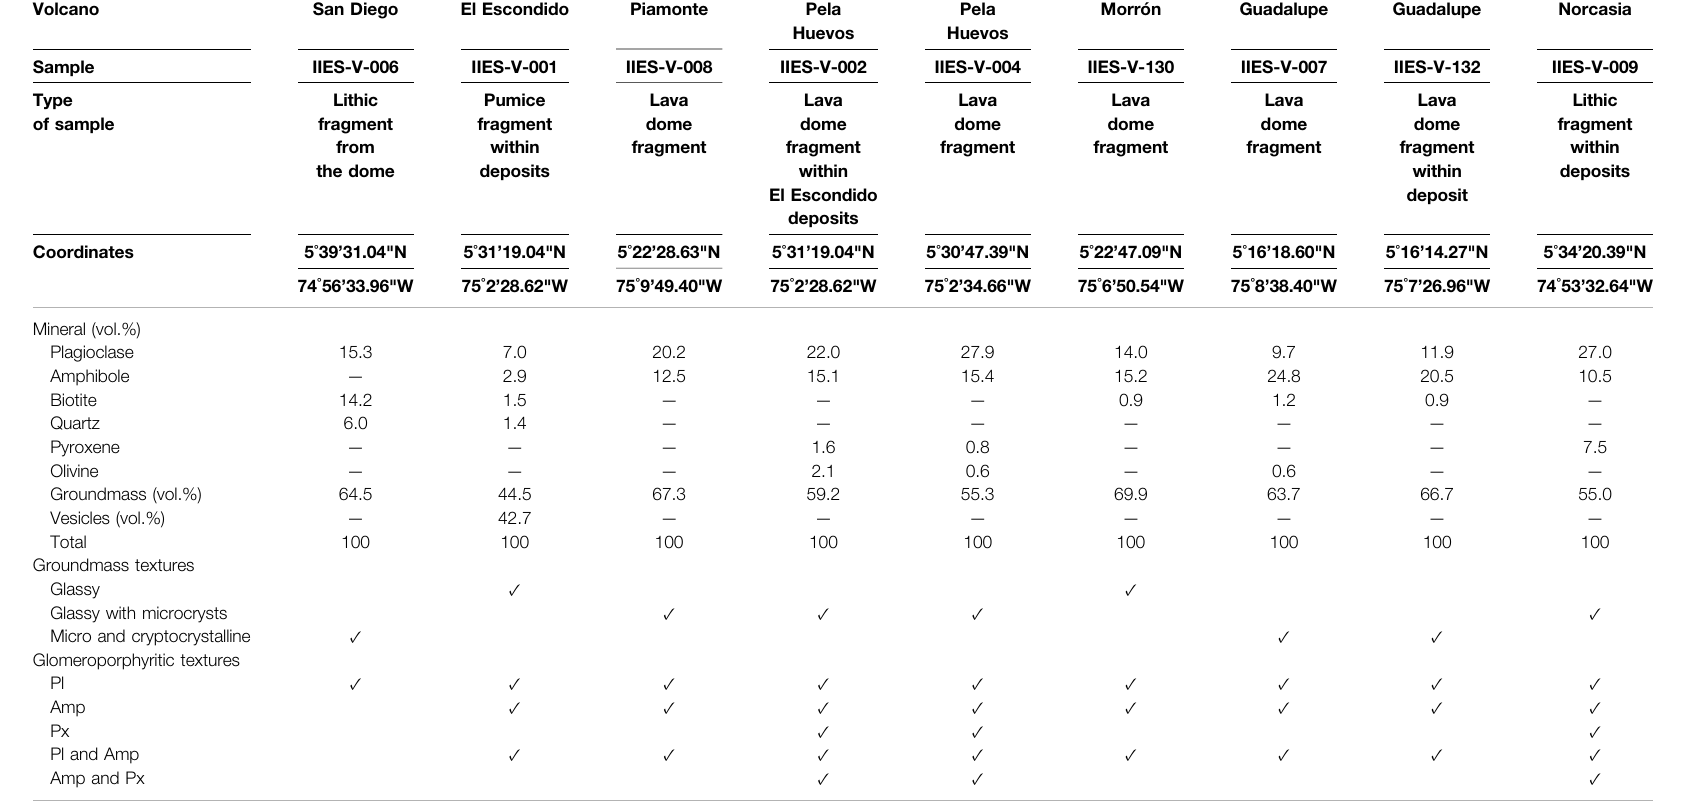
Pela Morrón Guadalupe Guadalupe Norcasia Huevos Huevos Lithic Lava Lava Lava Lava Lithic Pumice Lava Lava fragment dome dome dome dome fragment fragment dome dome within fragment fragment fragment fragment from within fragment fragment deposits within the dome deposits within deposit El Escondido deposits — — — — — — — — — — — —